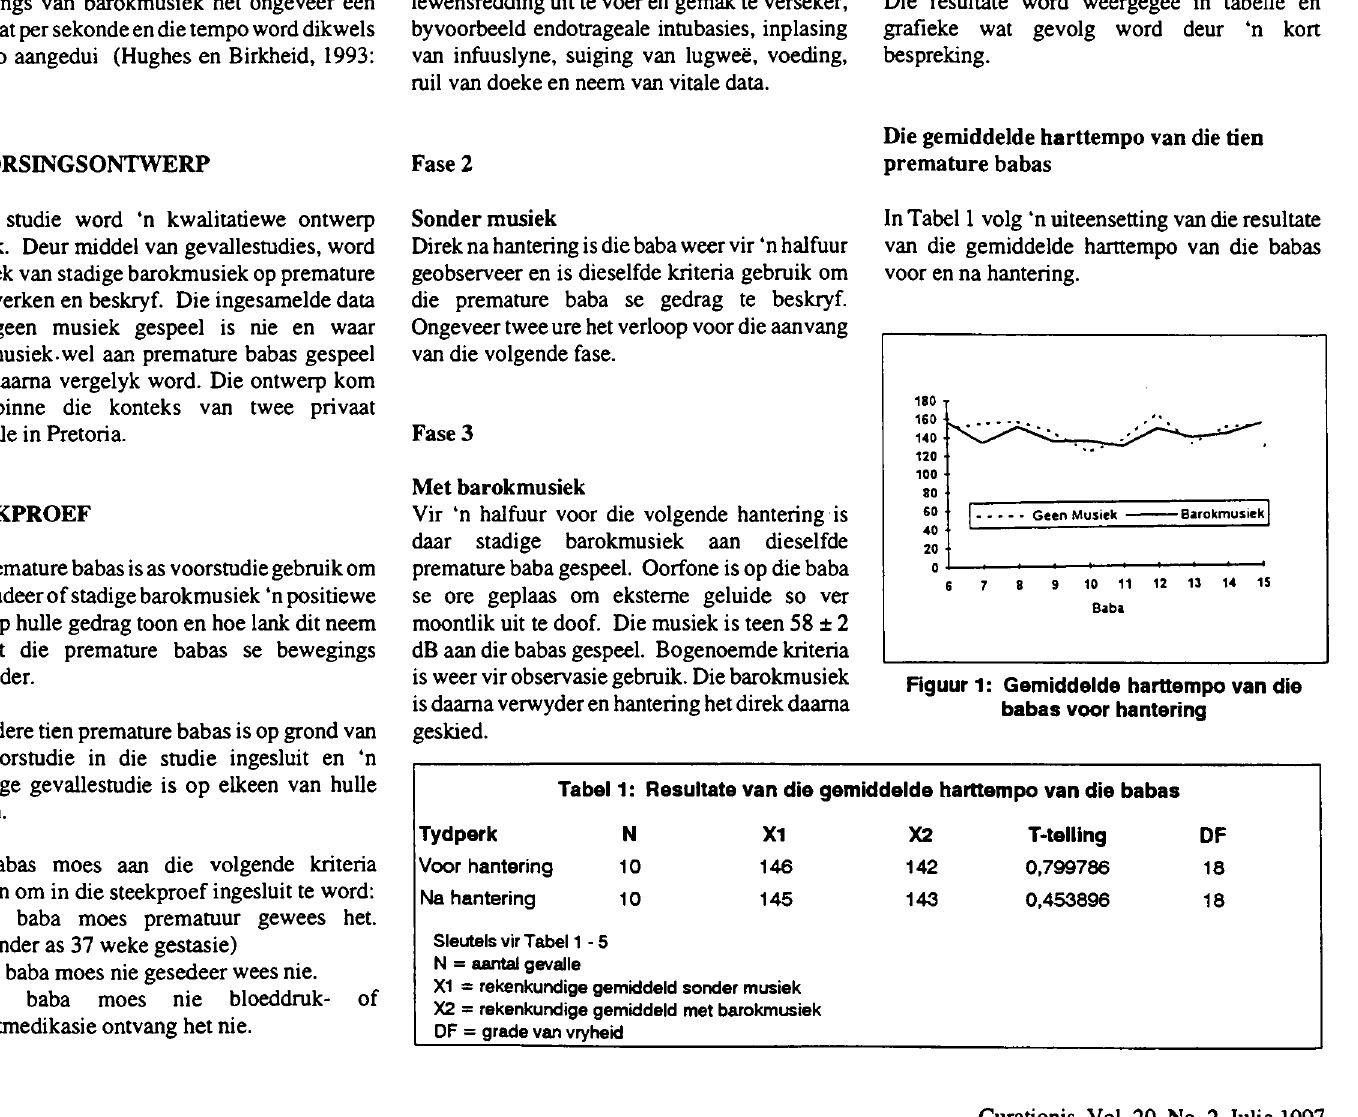
Tabel 1: Resultate van die gemiddelde harttempo van die